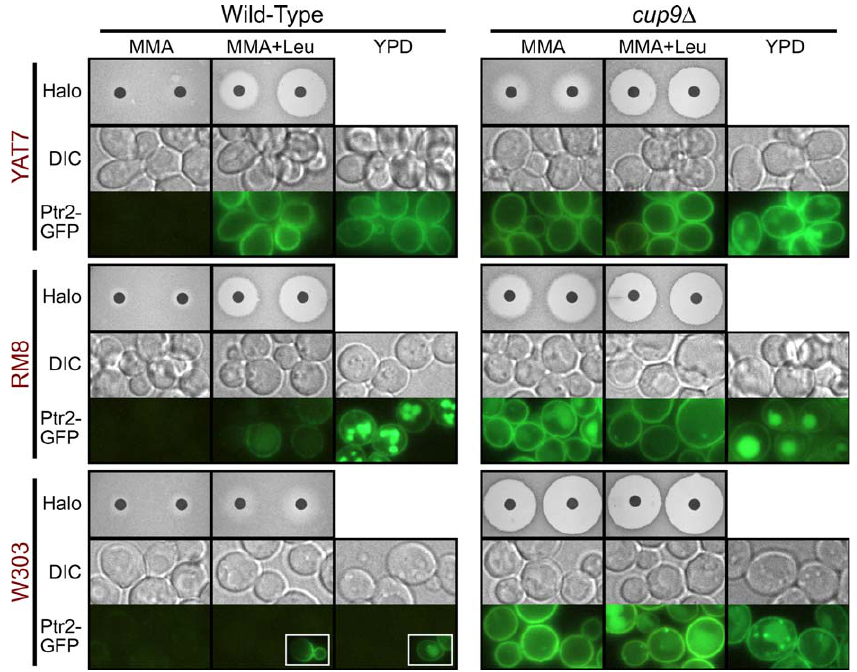
Figure 8. Inter-Strain Variation in PTR2 Expression and Sensitivity to the Toxic Dipeptide Ala-Eth Media composition and the absence of Cup9p affect expression of GFP-tagged PTR2 and Ala-Eth toxicity. Three types of media were tested: MMA, MMA þ Leu, and YPD. ‘‘ MMA ’’ refers to minimal nitrogen medium containing 1 mg/ml allantoin as the nitrogen source. ‘‘ þ Leu ’’ refers to the addition of 30 l g/ml leucine, an inducer of PTR2 expression. YPD is a standard rich S. cerevisiae medium; the presence of methionine precludes its use for the halo assay. The left and right discs in each halo assay panel contained 0.1 l moles and 0.2 l moles of Ala-Eth, respectively. Microscopy was conducted using cells grown to log phase in the indicated media. Three strains were imaged: W303, RM8, and YAT7. In each strain, the endogenous PTR2 gene contained a C-terminal tag consisting of a FLAG epitope, two copies of GFP, and a 6xHis tag. The insets depict representative cells from the small subpopulation of W303 cells that exhibited fluorescence. DOI: